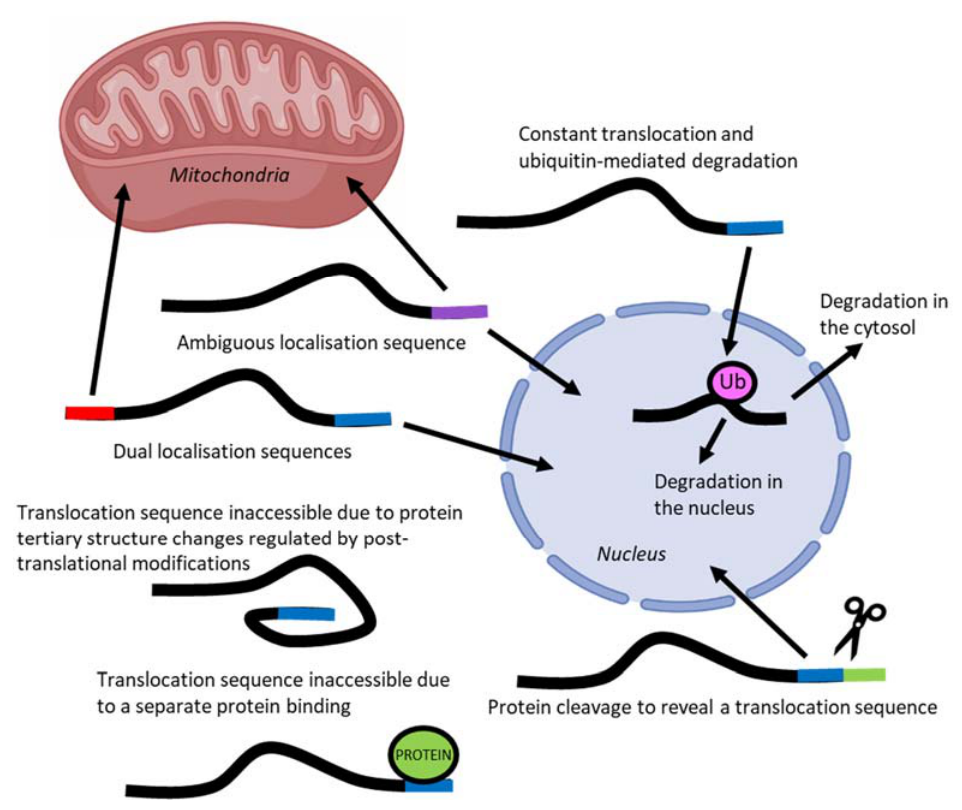
Figure 4. Regulation of protein translocation may occur through one or several of these mechanisms, each of which can additionally be controlled by post ‐ translational modifications.